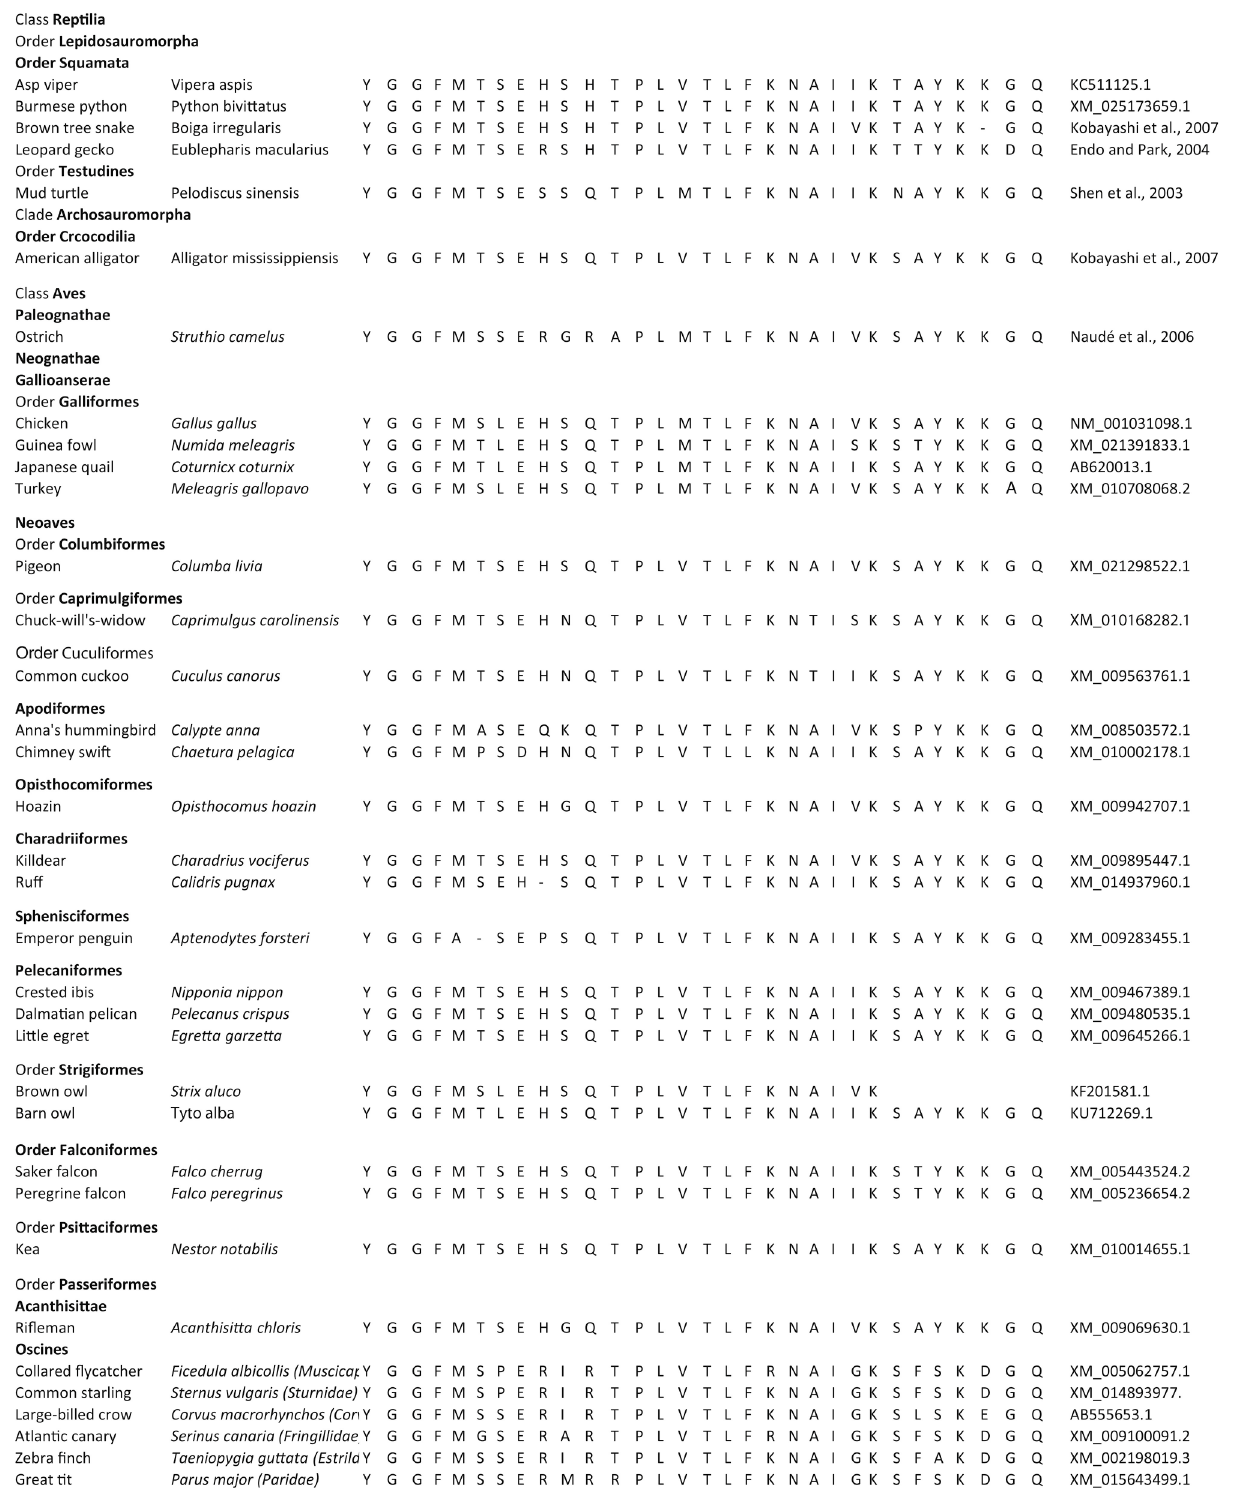
Frontiers in Physiology |